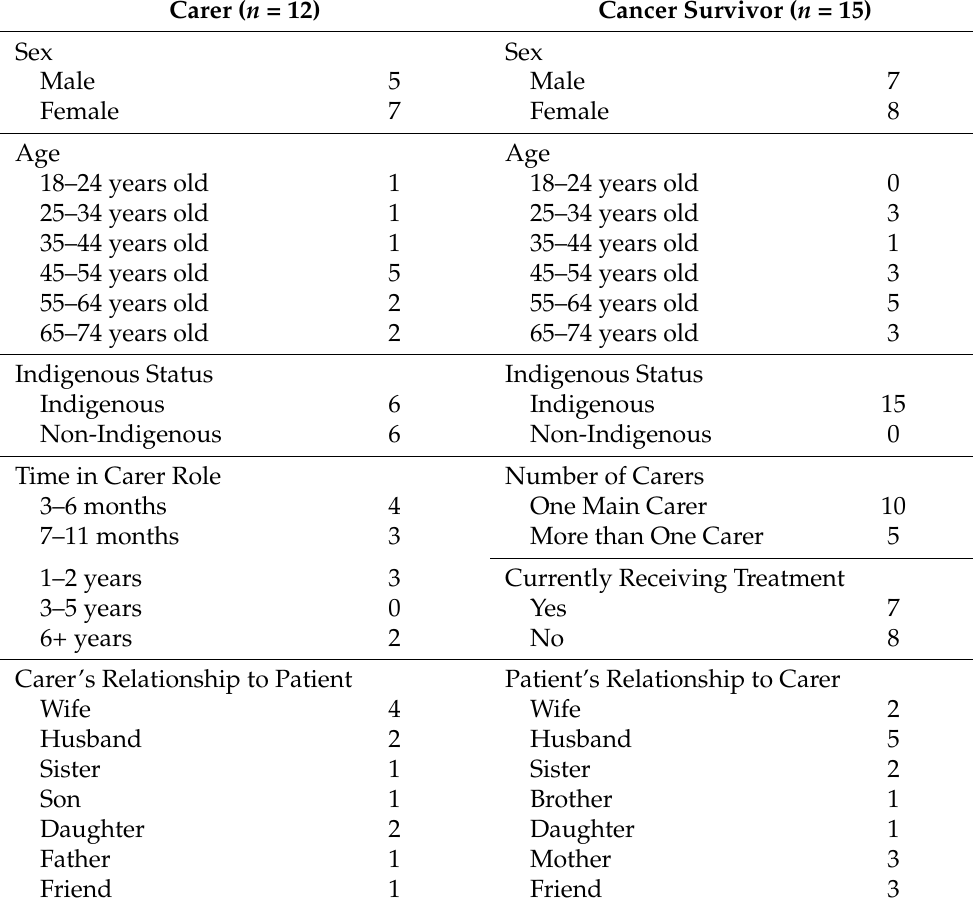
Table 1. Demographic and clinical characteristics of participants ( N =